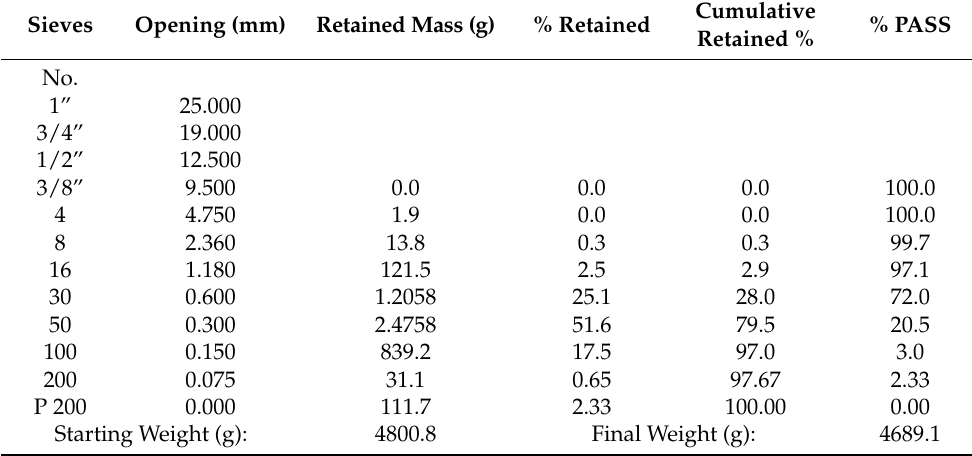
Table 2. Granulometry of clay